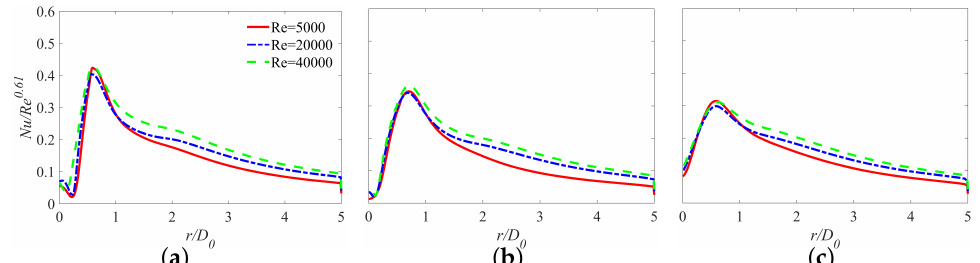
Figure 22. Nusselt number and Reynolds number scaling relationships for the straight nozzle at ( a ) H = 0.5, ( b ) H = 2, and ( c ) H = 4.